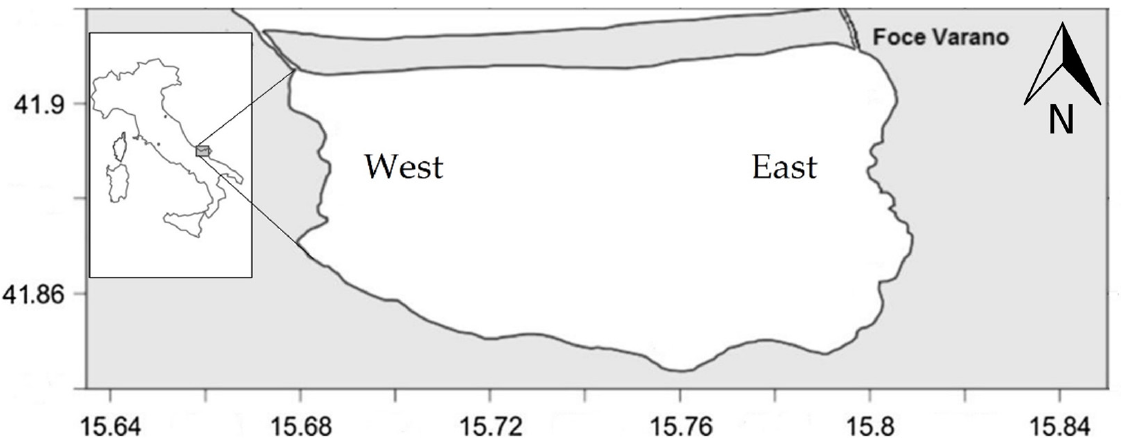
Figure 1. Study area: Varano lagoon with W and E zones.